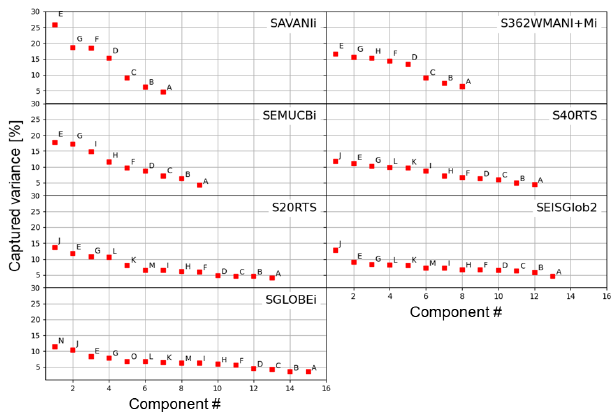
Figure 2. Captured variance by the PC varimax method, applied to the isotropic part of the seven tomography models used in this study. The number of components is chosen such that during the PCA, we only keep the components explaining more than 1% of the variance, which occurs after 7 (SAVANIi) to 15 (SGLOBE-ranii) components. The varimax PCs are sorted alphabetically from the shallowest one to the deepest